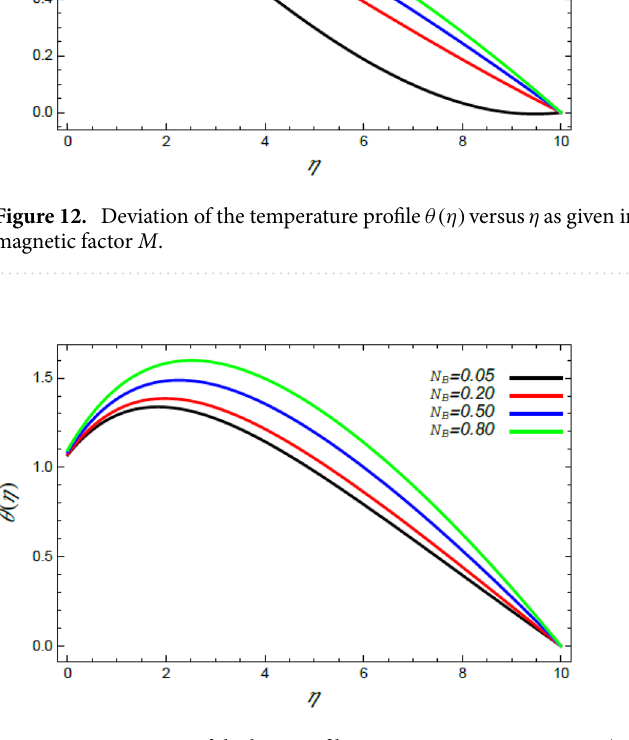
Figure 13. Deviation of the heat profile θ(η) versus η as given in Eq. (66) to illustrate the impact of the Brownian motion factor N B .